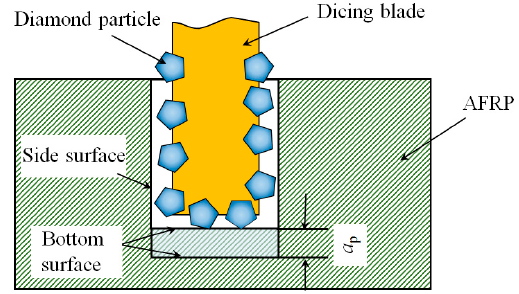
Figure 8. Schematic diagram of material surface during dicing.